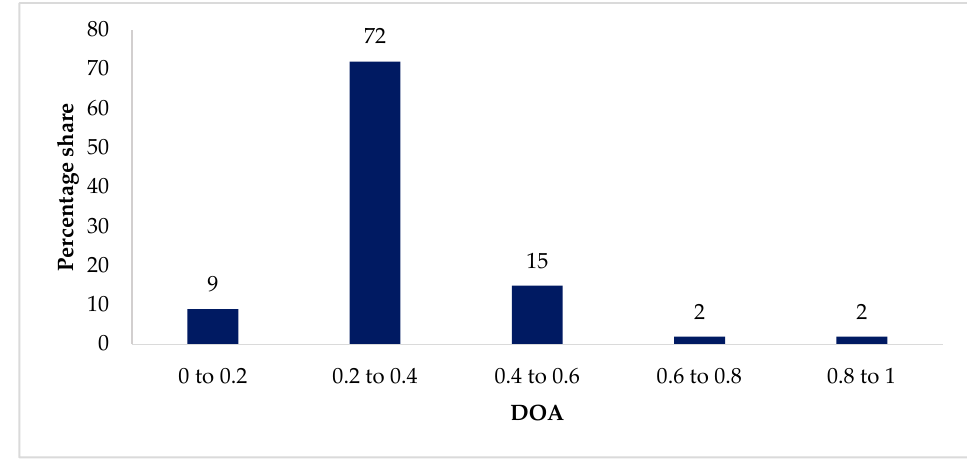
Figure 10. Total number of case studies considering each of the eight criteria.